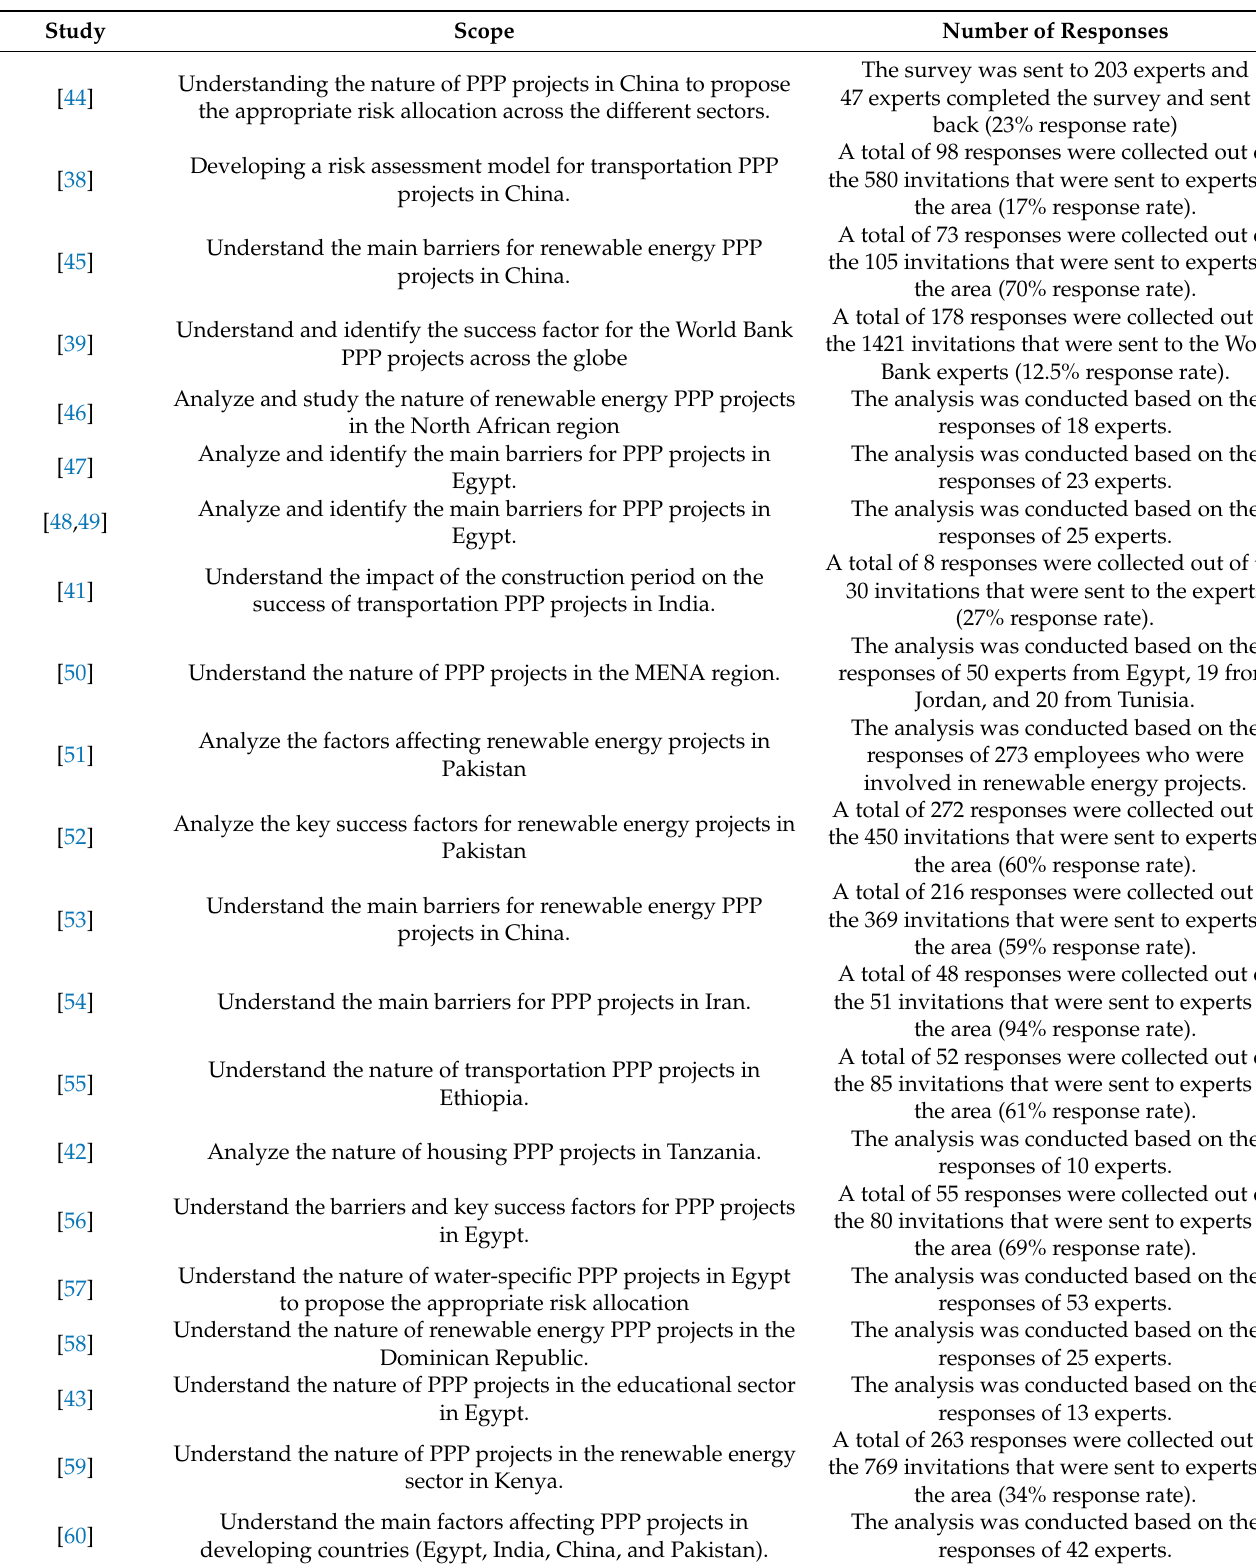
Table 1. Summary of previous surveys that utilized questionnaire surveys for understanding and analyzing different PPP